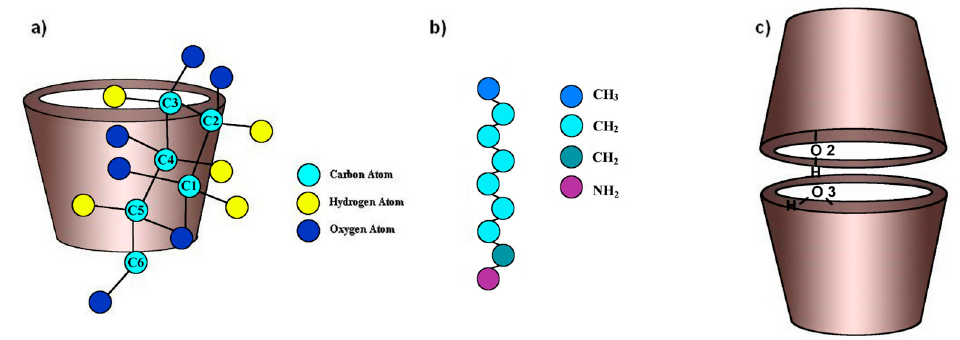
Figure 6. Schematic representations of: ( a ) α -CD; ( b ) octylamine guest molecule; and ( c ) inclusion- compound dimer.